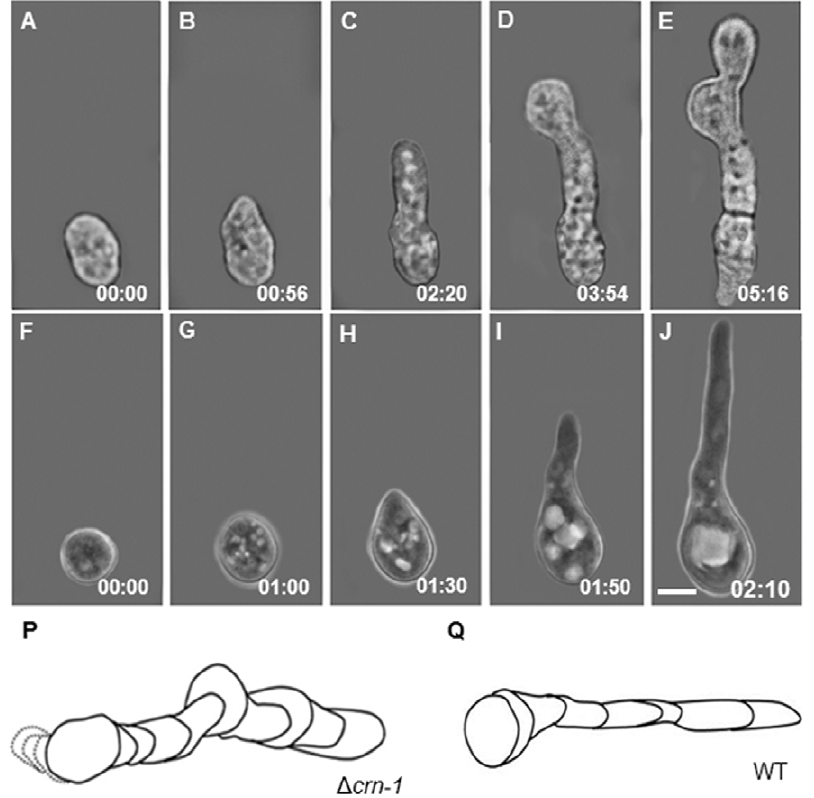
Figure 9. Conidial germination. (A–E) Time series of the D crn-1 mutant by bright field microscopy and (F–J) WT strain by phase contrast microcopy. Reconstruction of the morphological differences during conidial germination of above sequences over longer time periods (K) D crn-1 mutant and (L) WT. Time in h:min. Scale bar=5 m m.